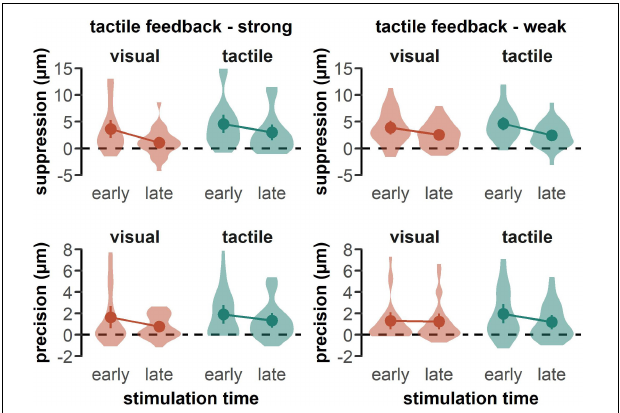
FIGURE 2 | Mean suppression and precision scores by feedback type. Data is plotted separately for both groups receiving a strong tactile feedback (left panel) and a weak tactile feedback (right panel) . Higher suppression and precision scores indicate a deterioration of tactile perception. Colored dots represent the mean across participants with error bars indicating the standard error of the mean. Shaded areas represent the data distribution smoothed with a kernel density